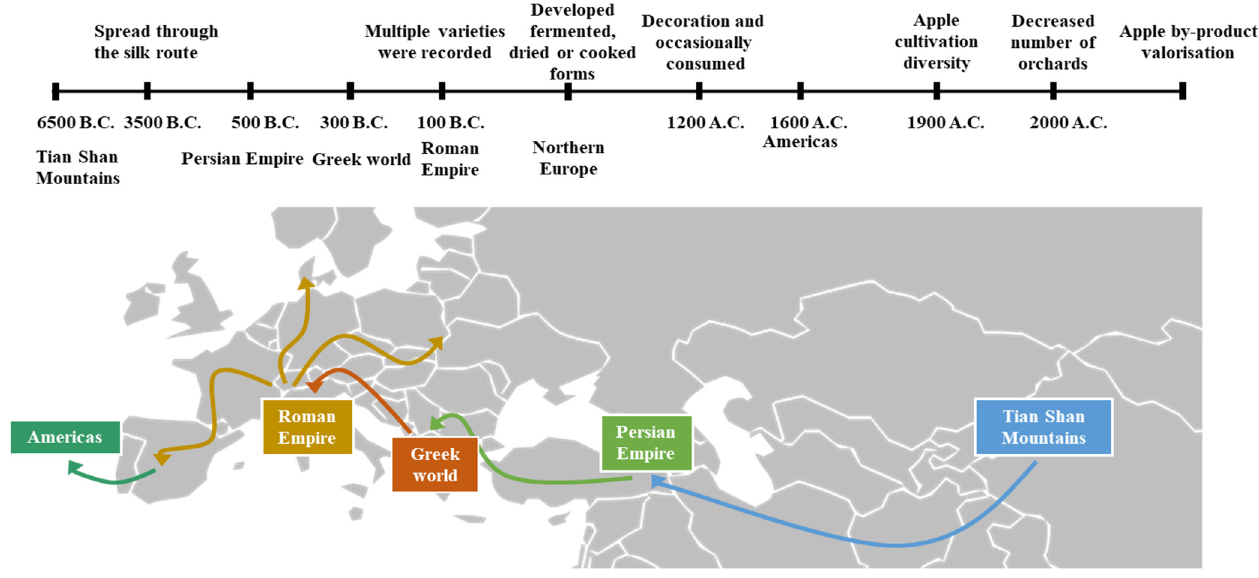
Figure 2. Evolutionary history of the cultivated apple.